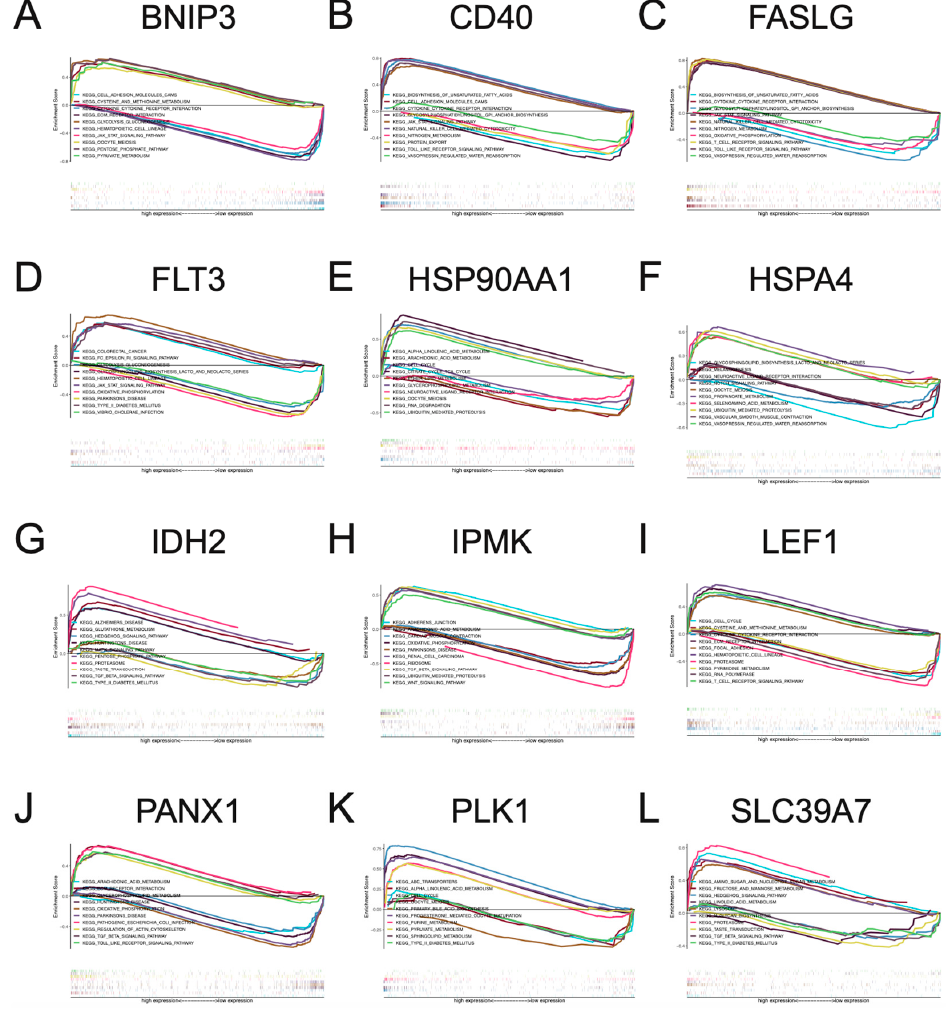
Figure 5. Multi-GSEA analysis of BNIP3 ( A ), CD40 ( B ), FASLG ( C ), FLT3 ( D ), HSP90AA1 ( E ), HSPA4 ( F ), IDH2 ( G ), IPMK ( H ), LEF1 ( I ), PANX1 ( J ), PLK1 ( K ), and SLC39A7 ( L ) in breast cancer.